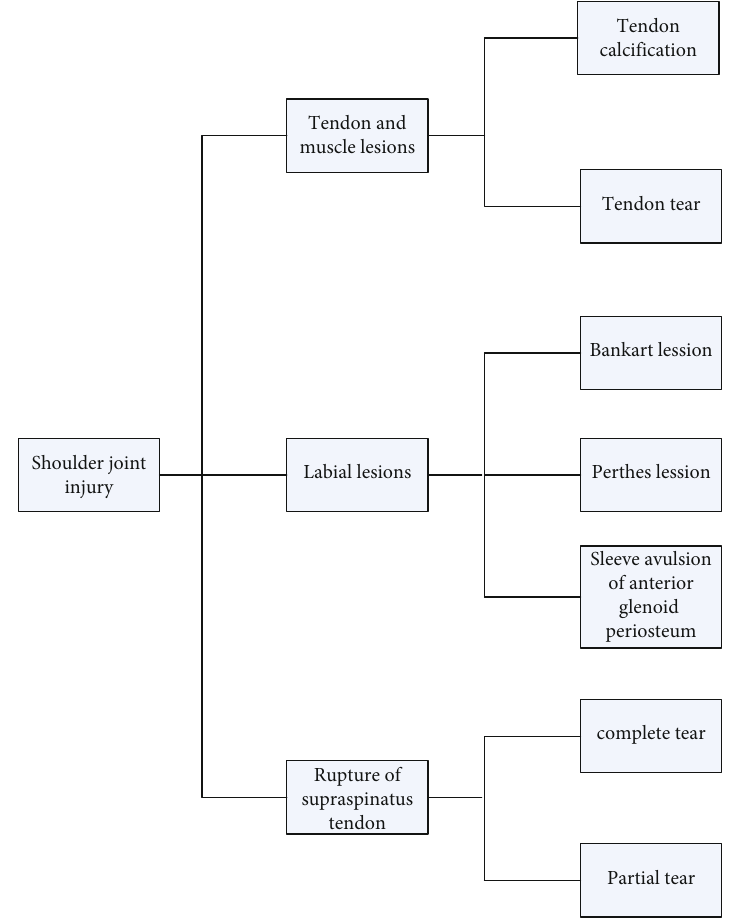
Figure 1: Main manifestations of shoulder joint